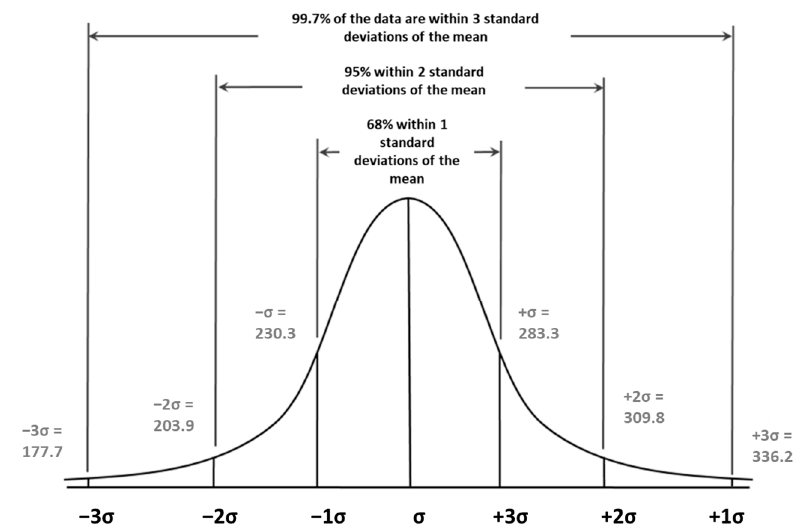
Figure 2. The normal distribution and range of variation in beer samples (gluten < LOD) spiked with 0.5 mg/kg PTW-Cubus. σ , coefficient of variation.